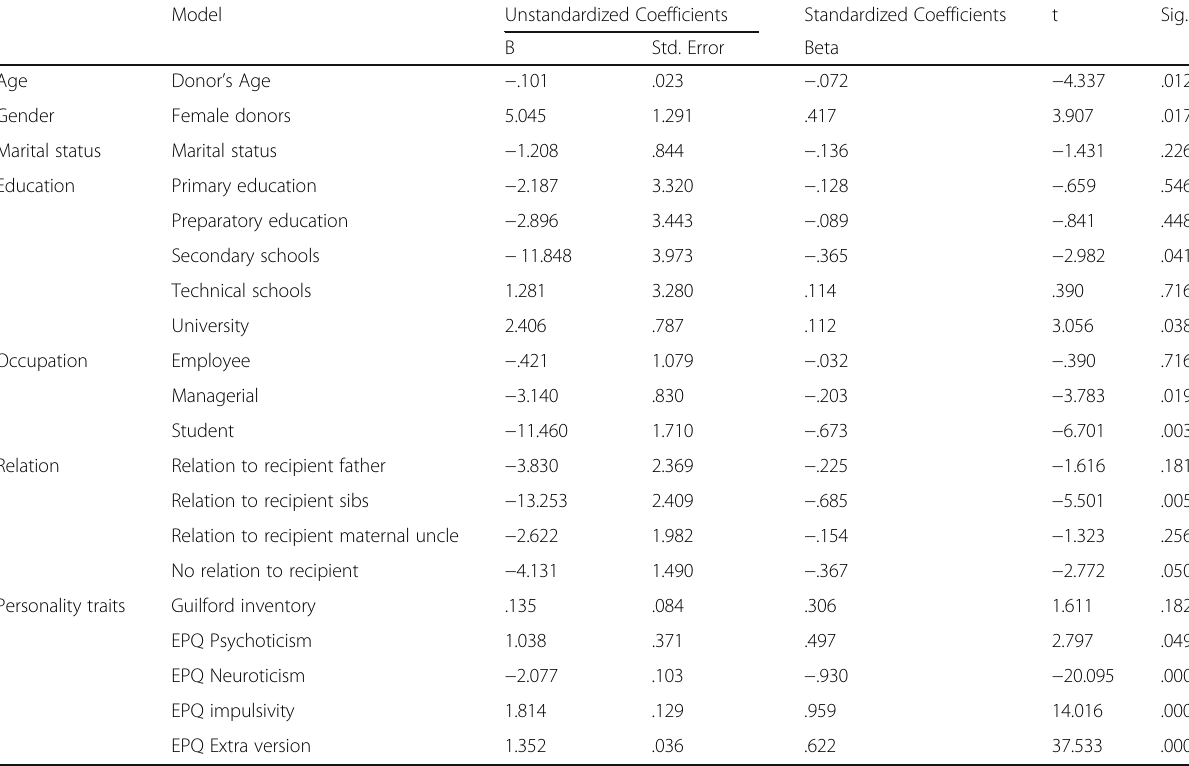
Table 4 Risk factors correlated with psychiatric morbidity